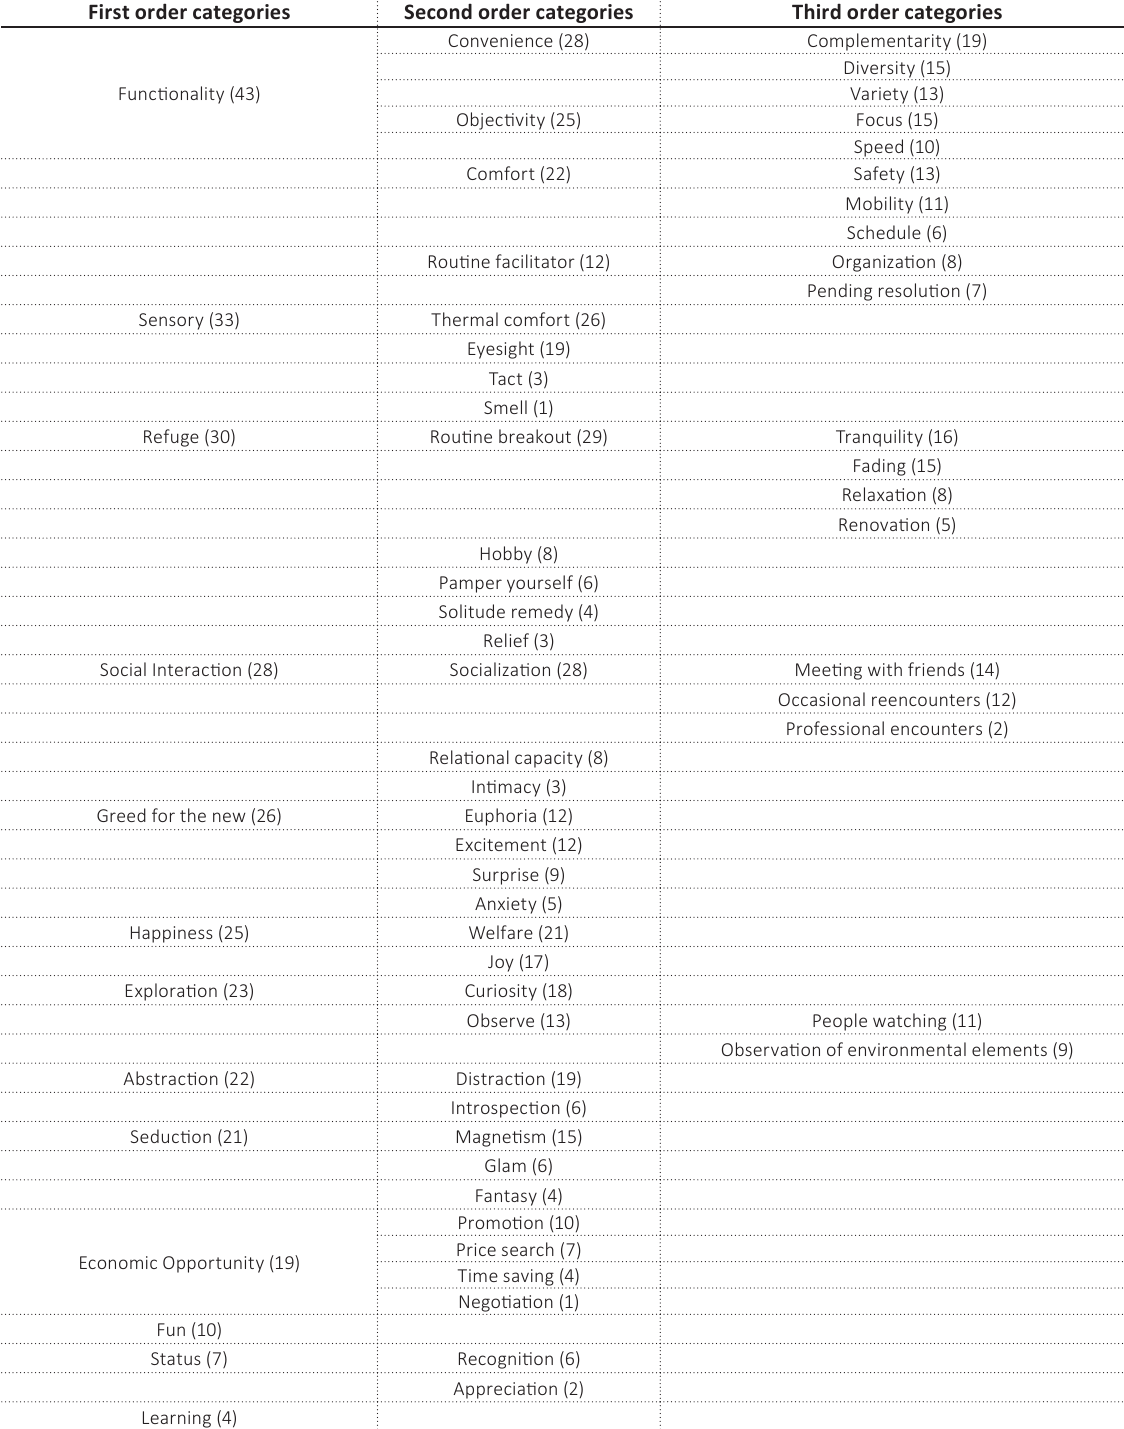
Table 2. Subcategories of Pleasant Experience First order